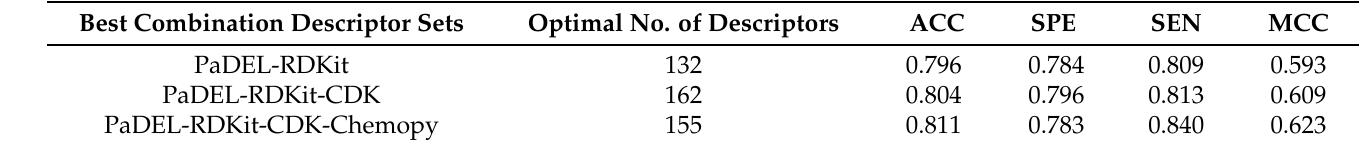
Table 3. Performance details of best combination descriptor